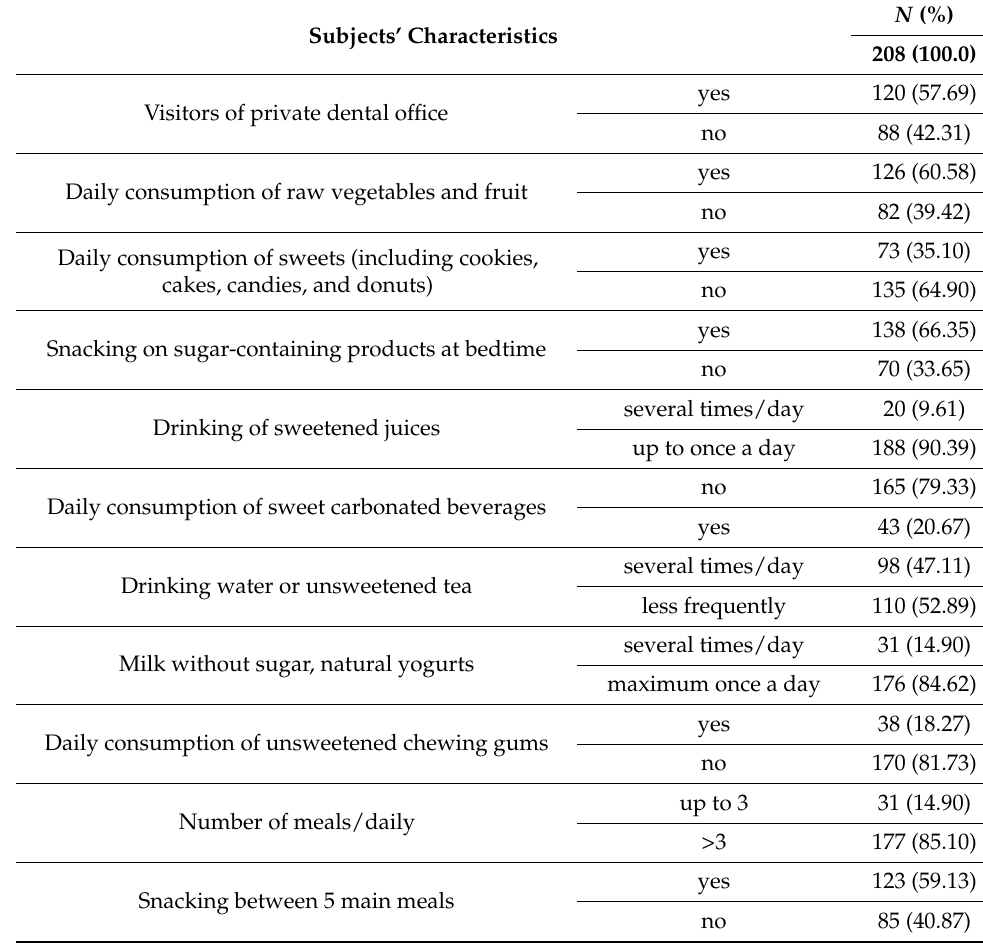
Table 3. The results of the questionnaire